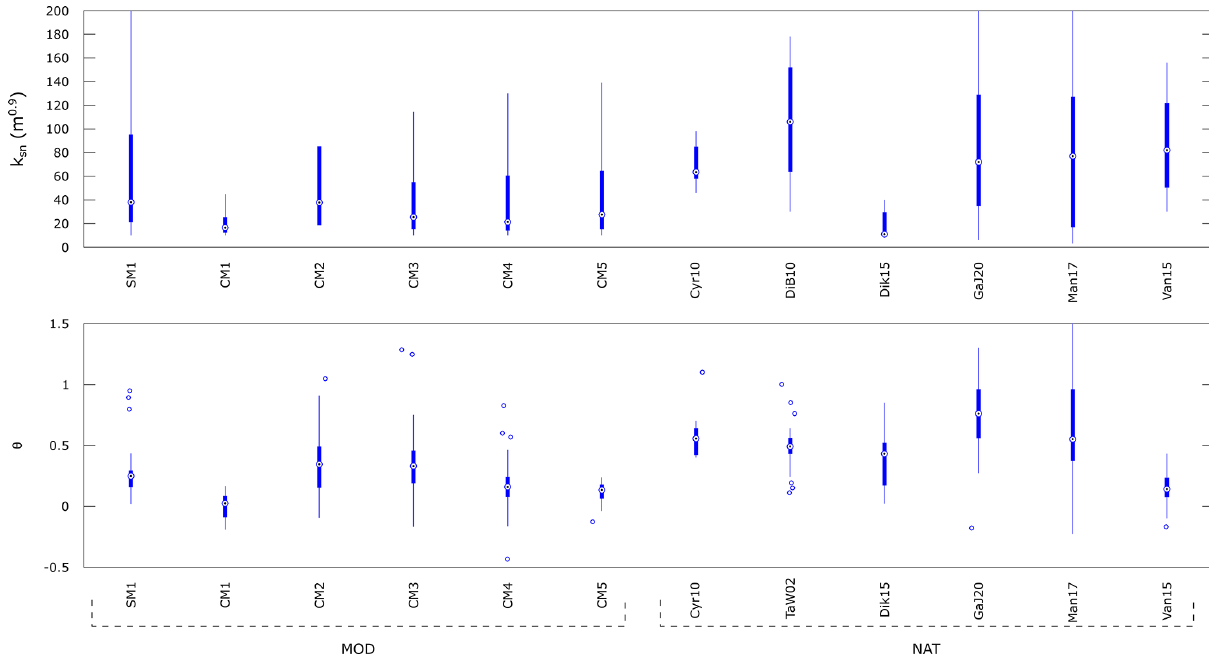
Figure 12. Steepness ( k sn ) and concavity index ( θ ) in the experiments and in nature (field data). We use θ ref = 0.45 for computing k sn . The black dots indicate the median, while the bottom and top edges of the blue box indicate the 25th and 75th percentiles, respectively. The thin blue lines cover data < 25th and > 75th percentiles that are not considered outliers, and the outliers are indicated by the blue empty dots. Cyr10: Cyr et al., 2010; DiB10: DiBiase et al., 2010; TaW02: Tucker and Whipple, 2002; Dik15: Dikshit, 2015; GaJ20: Guha and Jain, 2020; Man17: Mandal et al., 2017; Van15: Vanacker et al.,